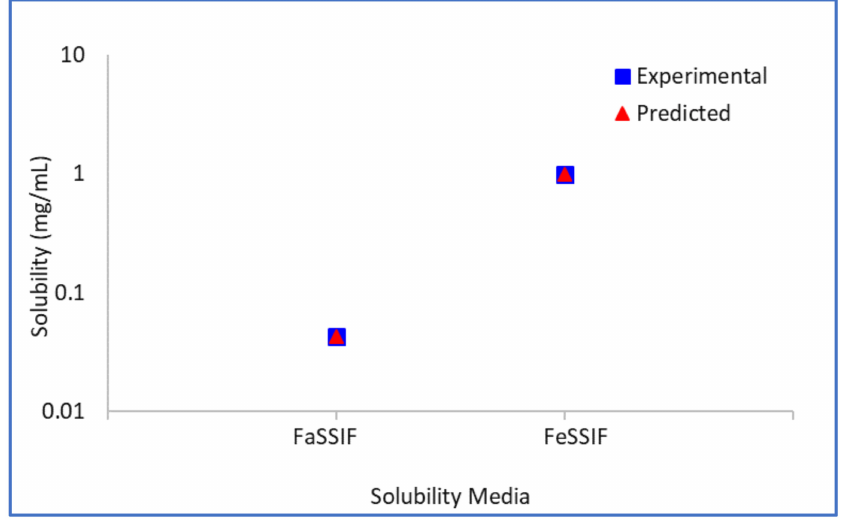
Figure 4. Model drug free form experimental vs. predicted biorelevant